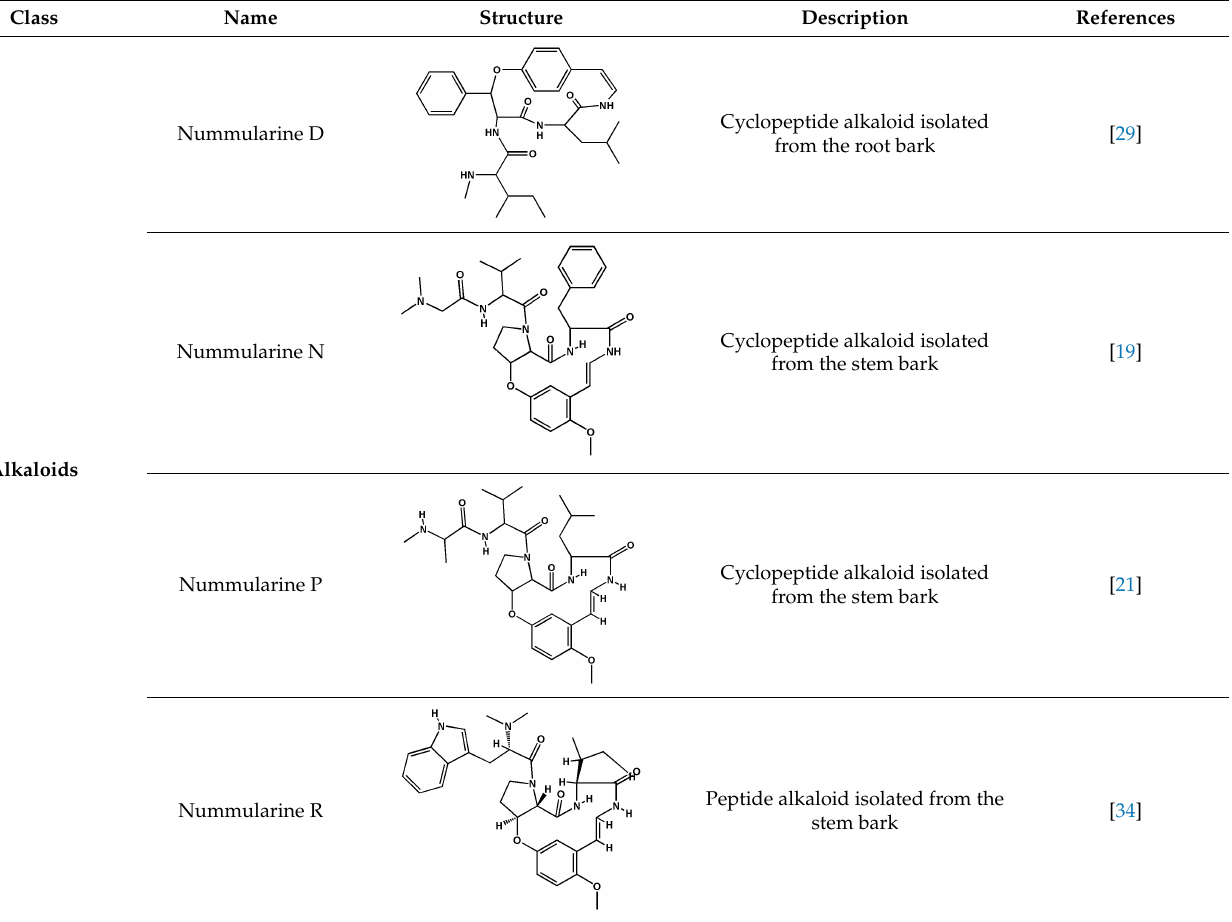
Table 2. Chemical structures of the main phytoconstituents in the stem bark, root bark, leaves, and fruits of Ziziphus nummularia .